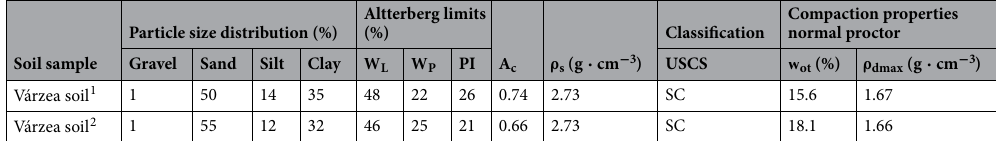
Table 1. Soil geotechnical characterization. Obs: A c -soil activity; 1,2 : samples from first and second sampling